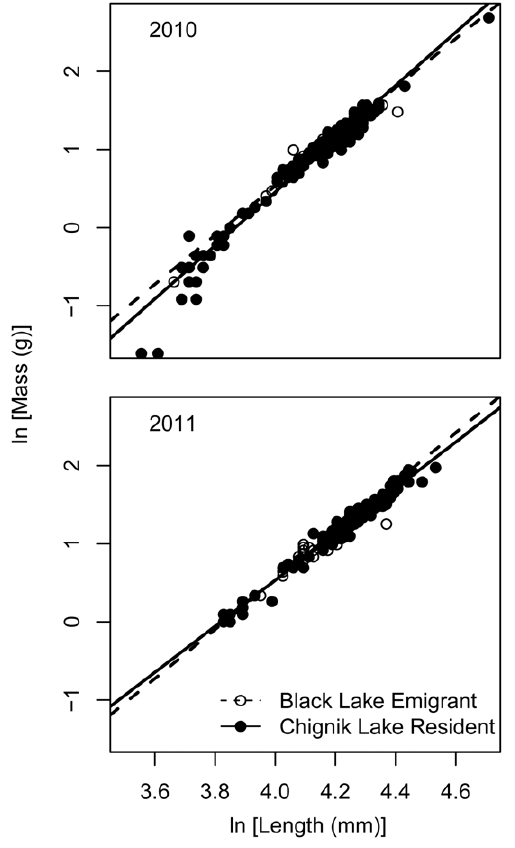
Figure 5. Length-mass relationship for sockeye salmon cap- tured in Chignik Lake by natal origin. These populations are referred to in the text as Black Lake emigrants and Chignik Lake residents. Circles are individual fish and the lines represent the AICc selected model. For 2010 and 2011, the best fit model contained different intercepts and slopes by natal origin. However, for 2011 this model differed less than 2 AICc units from a model with the same slope and intercept for both stocks (Table 2).